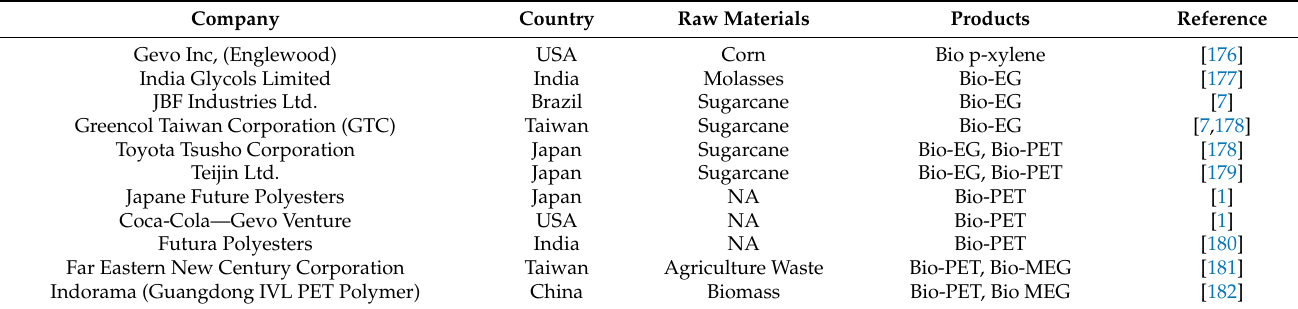
Table 7. Industrial-scale of renewable bio-based EG and PET product and precursors. Company